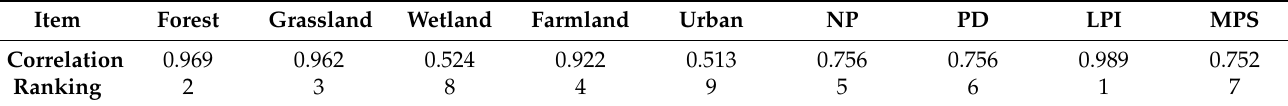
Table 5. Correlation results of ecosystem types and landscape pattern index changes in 9 intensities zone. Item Forest Grassland Wetland Farmland Urban NP PD LPI MPS Correlation 0.969 0.962 Ranking